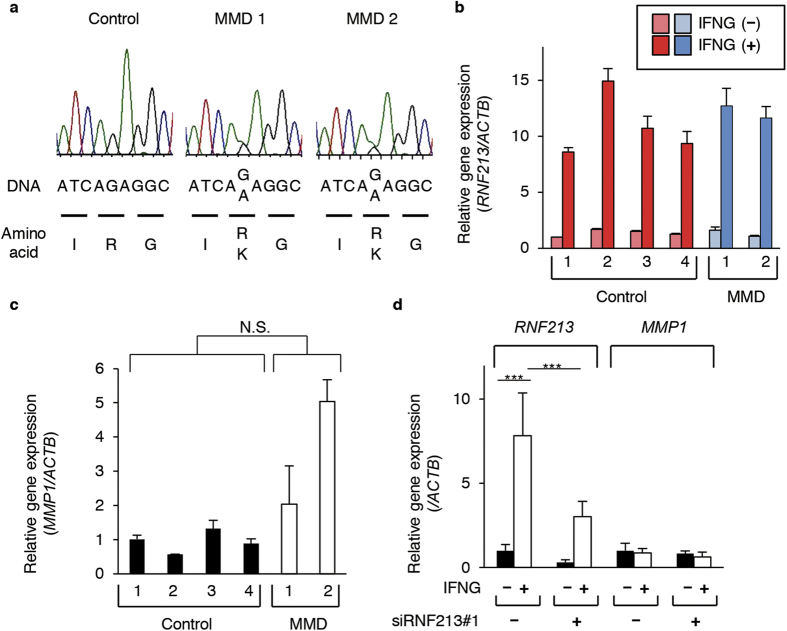
Comparative analysis of MMP1 expressions in fibroblasts from healthy controls and MMD patients carrying the R4810K variant of RNF213.(a) Sanger sequences for the target region of RNF213. Note that healthy control (Normal) are have the wild-type allele, while two MMD patients (MMD1 and 2) carry a heterozygous c.14756G>A (R4810K) mutations. (b) Relative RNF213 expressions and their responses to IFNG treatment in the fibroblasts from 4 healthy controls (Normal) and 2 MMD patients. Data are shown as mean ± SD values of qPCR assays in three independent assays. (c) Relative expressions of MMP1 transcripts in fibroblasts from 4 individuals of healthy control and 2 MMD patients. Values are shown as mean ± SD (n = 3), and analyzed using Student’s t-test. N.S., not significant. (d) Relative RNF213 and MMP1 expressions in control fibroblasts with or without treatment by IFNG and siRNF213#1 (mean ± SD, n = 3, using Tukey’s HSD test, ***p < 0.001).